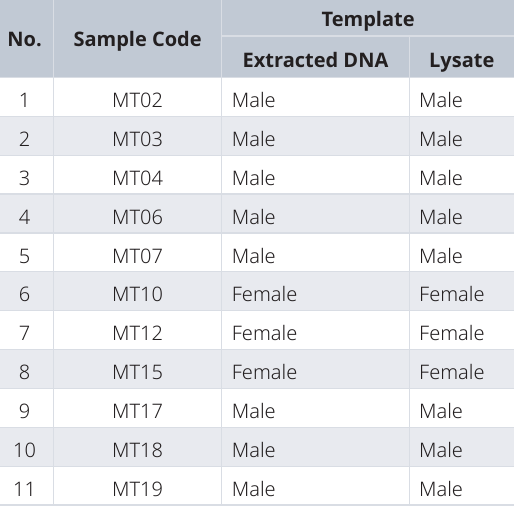
Table 2. Identified sex of Maleo ( Macrocepalon maleo ) based on molecular sexing with different